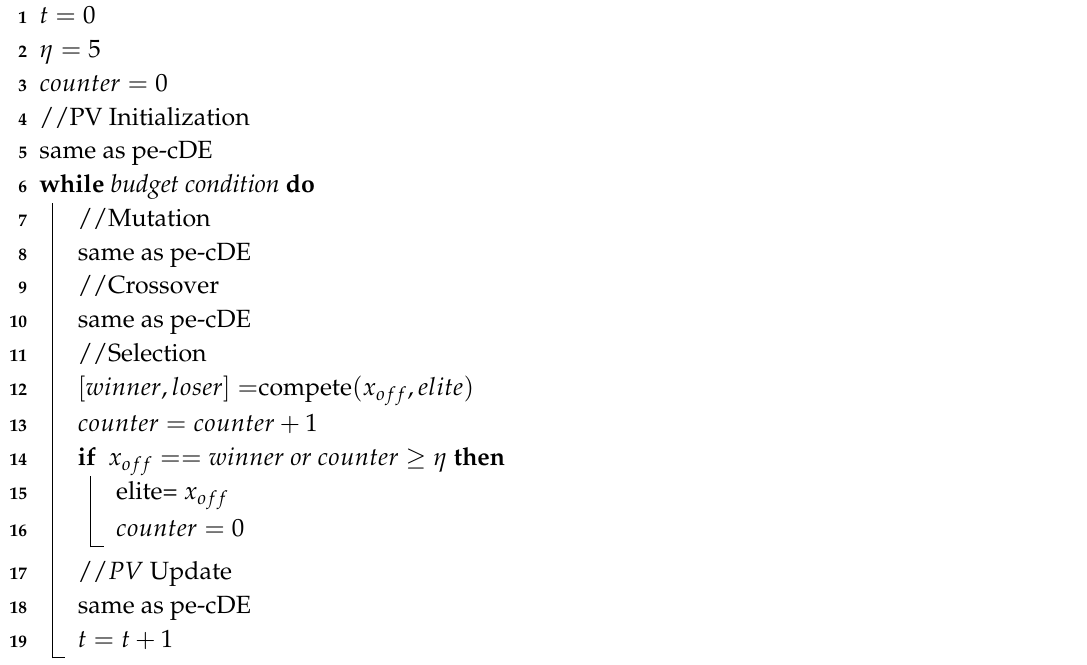
Algorithm 3: ne-cDE algorithm pseudocode